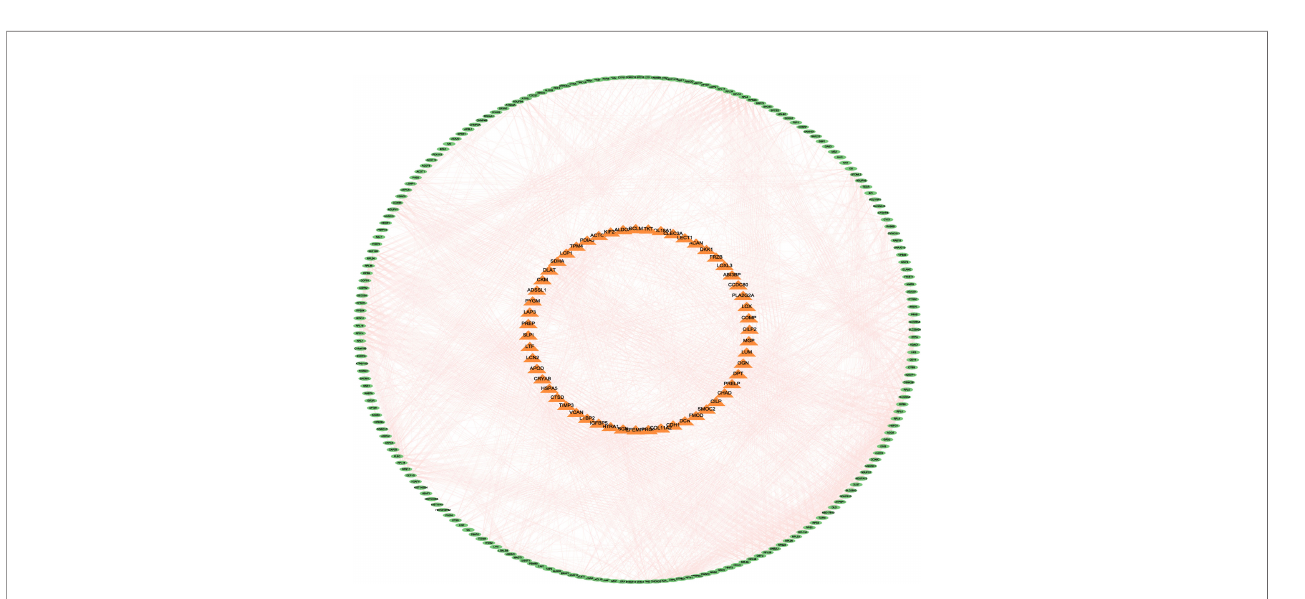
FIGURE 8 | The differential proteins were divided into up-regulated proteins and down-regulated proteins by constructing a PPI network map. Outer circle proteins indicated up-regulated proteins and inner circle proteins indicated down-regulated